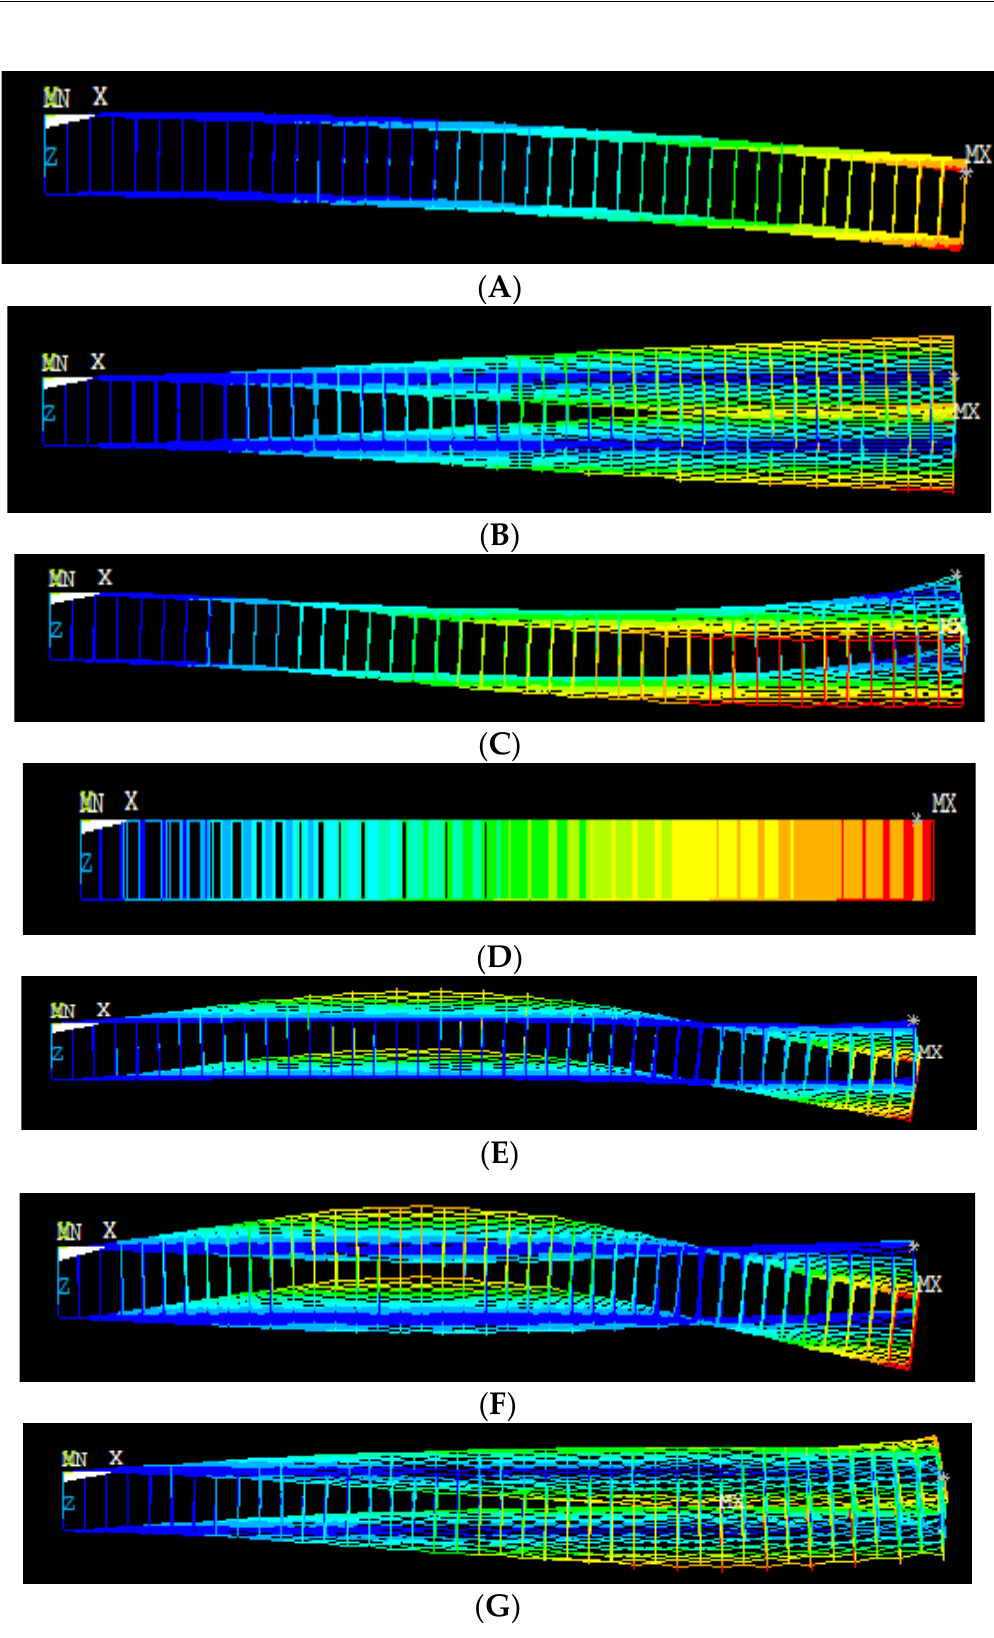
Figure 17. ( A – G ) Different mode shapes of cantilever DLG (20, 0) with length 50 nm (front view of mode shape).